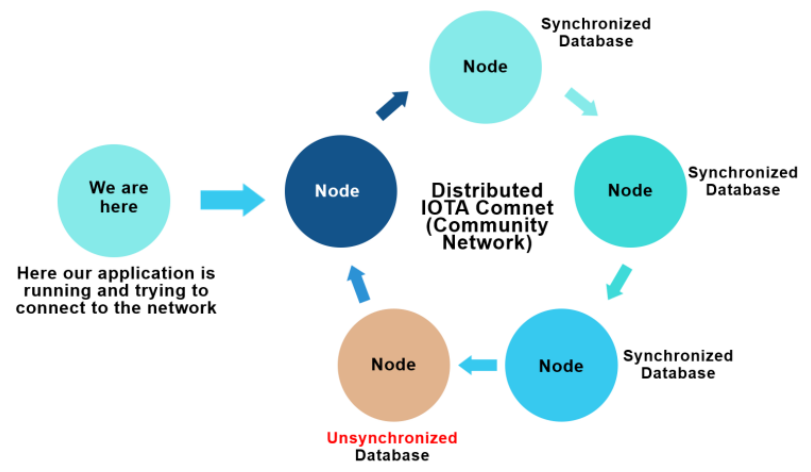
Figure 3. Network of IOTA nodes. Presently, Hornet is the official second full node after IOTA IRI for the IOT devices or the low power client devices that can even run under 300 MB of available RAM. Moreover, we installed the Hornet community network (Comnet) on the Ubuntu 18.04, VPS. We used Contabo VPS for the setup of a Hornet node and remotely accessed it using the